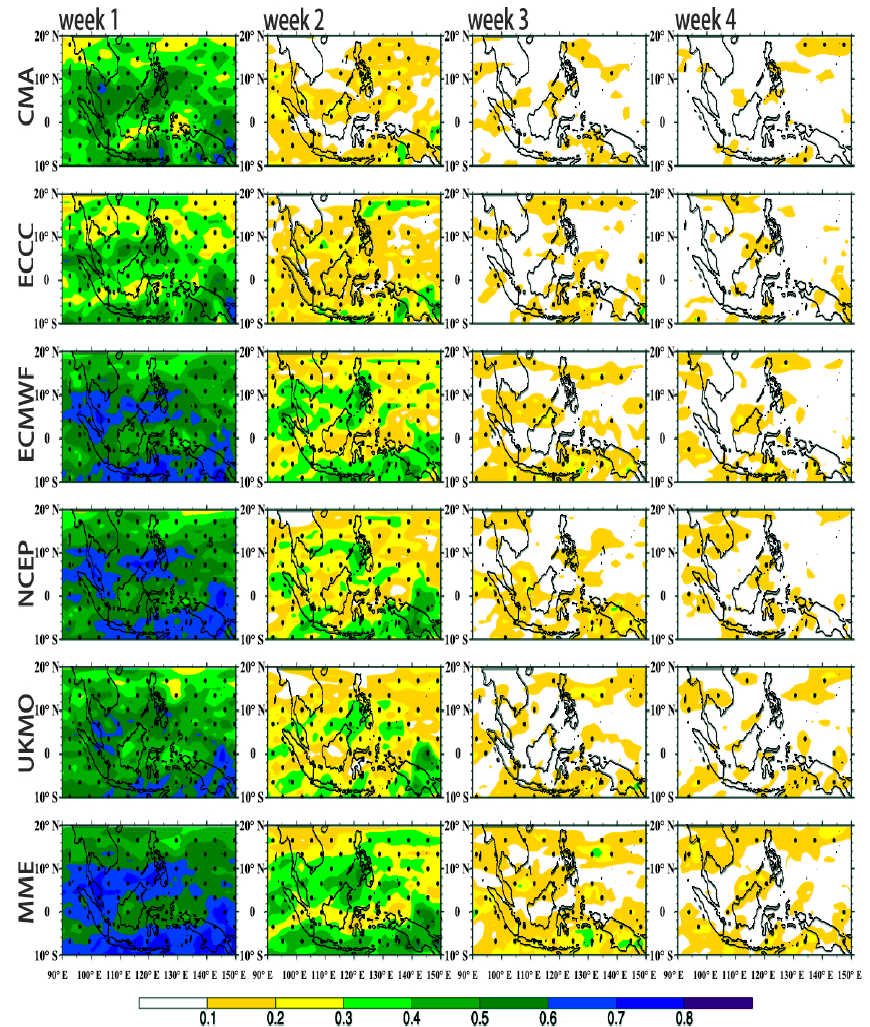
Figure 2. Spatial distribution of temporal correlation coe ffi cient (TCC) scores of precipitation anomalies in May–June–July–August–September (MJJAS) for China Meteorological Administration (CMA), Environment and Climate Change Canada (ECCC), European Centre for Medium-Range Weather Forecasts (ECMWF), National Centers for Environmental Prediction (NCEP), the UK Met O ffi ce (UKMO), and the 15-member MME (from top to bottom). The 1st, 2nd, 3rd, and 4th columns are predictions for lead weeks 1–4, respectively. Areas exceeding the 95% confidence level are